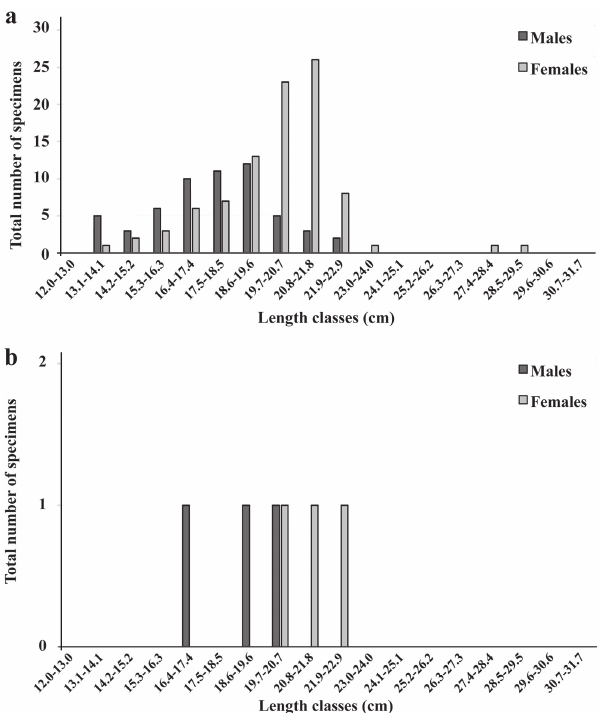
Fig. 3. Distribution of Loricariichthys melanocheilus in the rio Ibicuí by length classes for separate sexes in point 1. a: Lagoon and b: River.